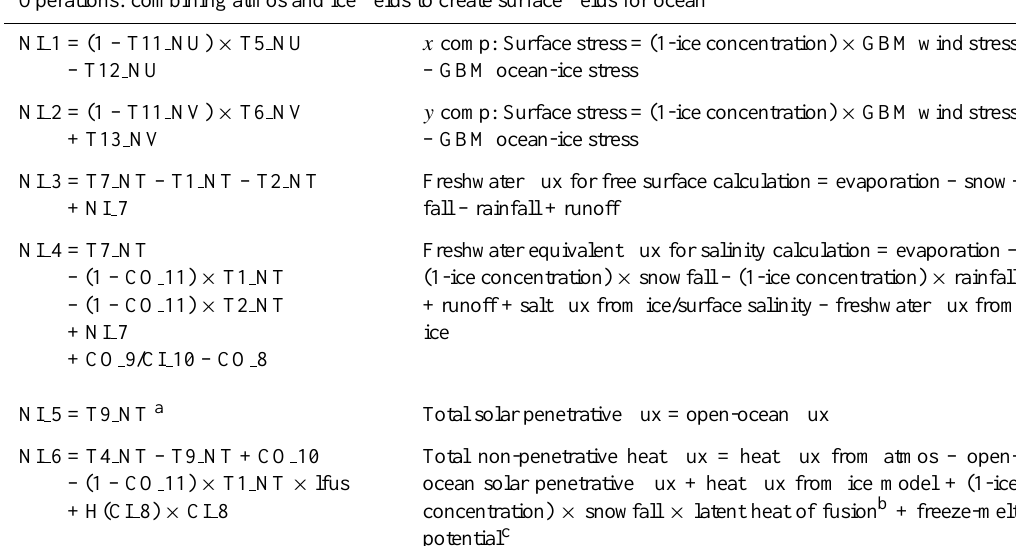
Table 1f. Details of combining the atmosphere and ice fields to create surface fields for the ocean in Fig. 4. These manipulations are in the NEMO subroutine CICE SBC OUT .